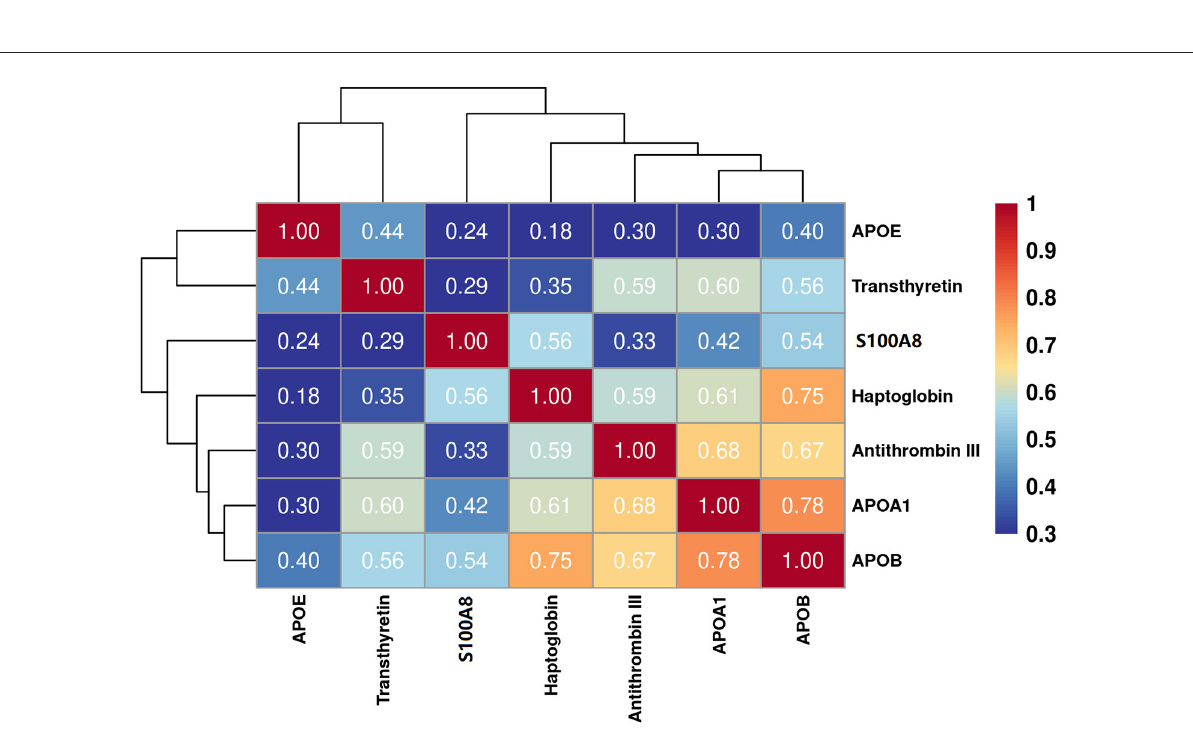
FIGURE3 Partial correlation analysis of the 7 differentially expressed proteins. The correlation values between any two proteins were presented in the